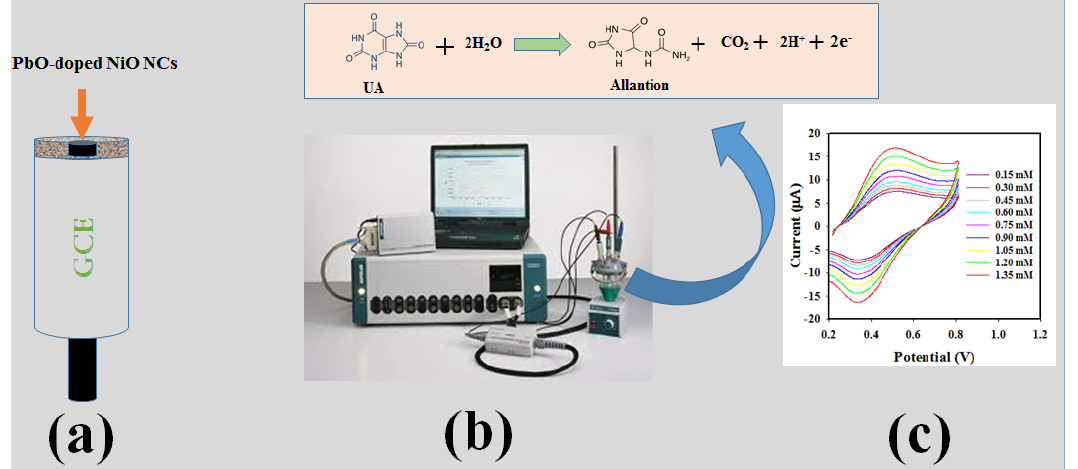
Scheme 1. Schematic presentation of UA electrochemical sensor applying voltammetric electrochem- ical approach. ( a ) GCE modification with PbO-doped NiO NCs, ( b ) Instrumental arrangement of sensor Auto-lab, and ( c ) the resulting data from the